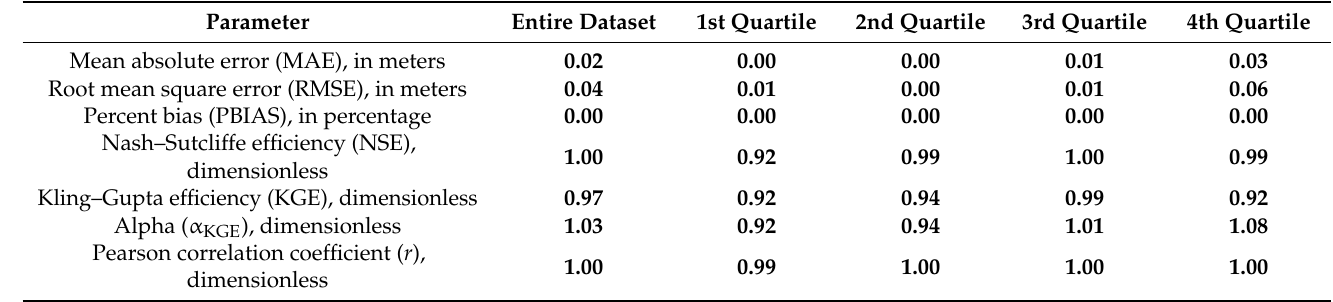
Table 3. Goodness-of-fit statistics associated with radar-based and USGS-streamgage-based stage measurements, values in bold indicate they meet this study’s criteria for satisfactory performance defined in Section